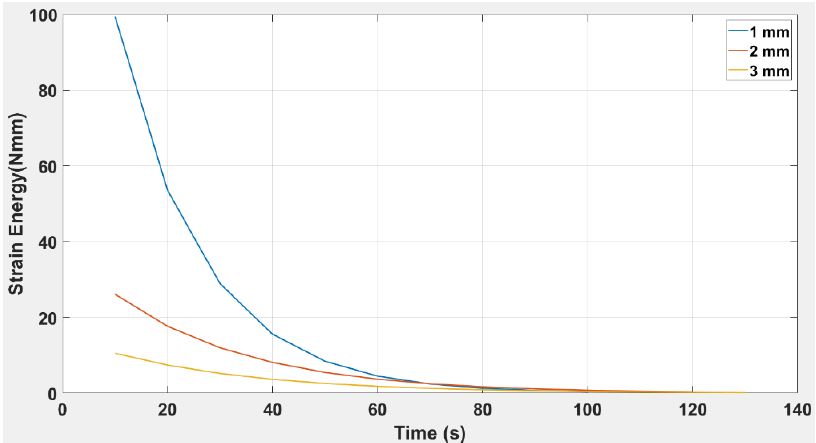
Figure 22. Strain Energy ver sus time for TPU “cross” beam structure of thicknesses : 1.0 mm, 2.0 mm, and 3.0 mm